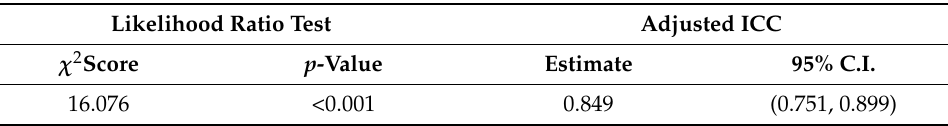
Table 5. Likelihood ratio test and intraclass correlation coefficient for the study on the differences between the manual method and ImageJ. ICC, Intraclass Correlation Coefficient; C.I., Confidence Interval.